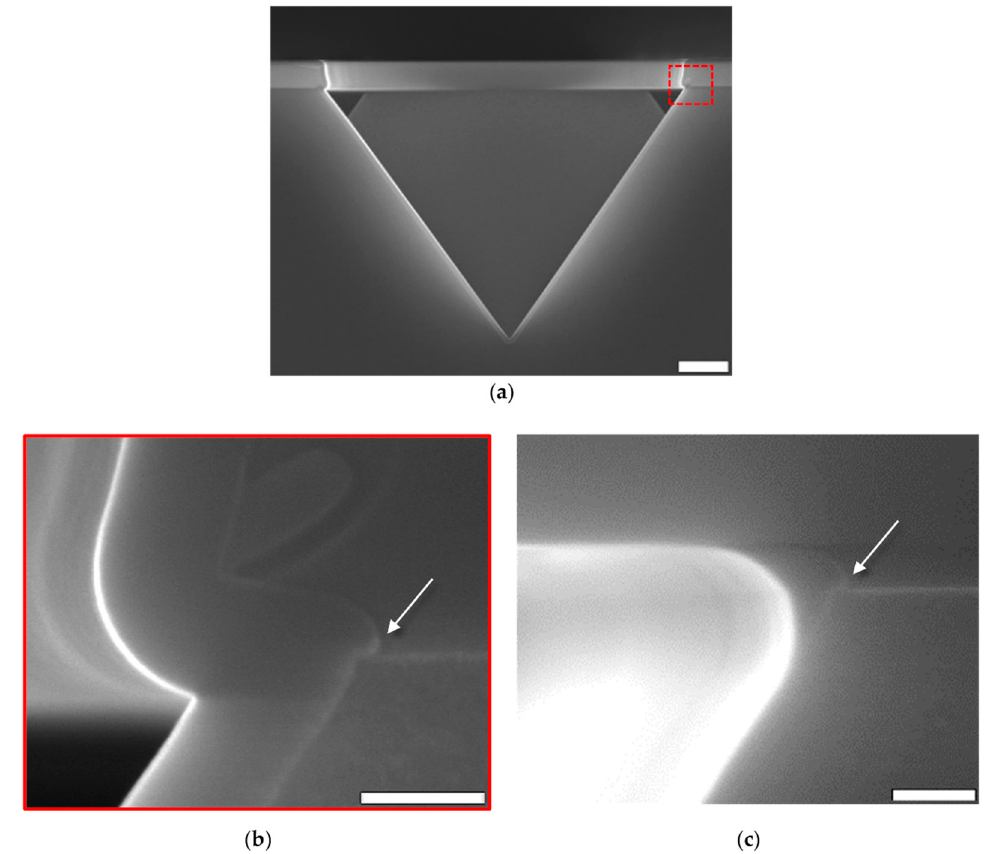
Figure 19. Cross-sectional SEM showing that Si 3 N 4 was conformally deposited prior to corner lithography on the G2 ( a ) and ( b ) zoomed section indicated in red also showing the extra etched corners as described. ( c ) is ( b ) after EF of 1.0. The white arrows indicate the undercut of the SiO 2 mask. Scalebars: ( a ) 1 µm and ( b , c ) 100 nm.